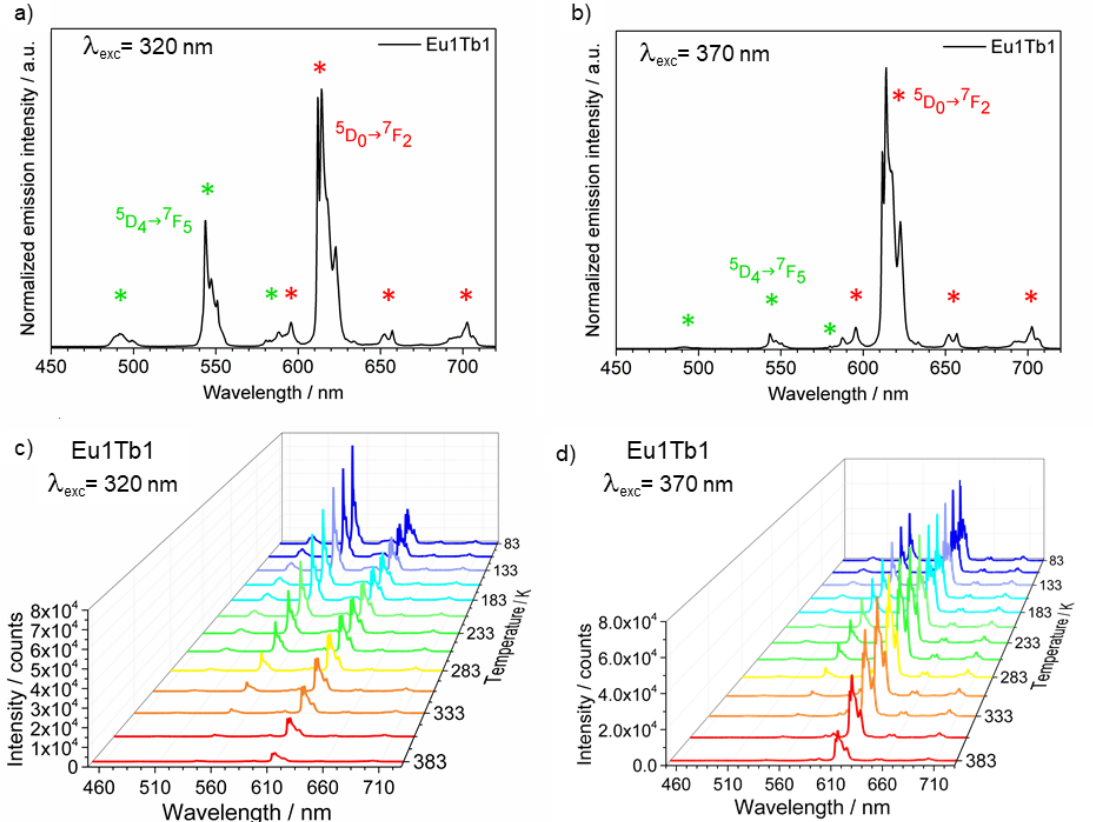
Figure 7. ( a , b ) Room temperature and ( c , d ) temperature-dependent emission spectra of sample Eu1Tb1 . ( a – c ) λ exc = 320 nm, ( b – d ) λ exc = 370 nm. In ( a , b ) Tb 3+ emissions are labelled with green asterisks, while Eu 3+ transitions with red ones.